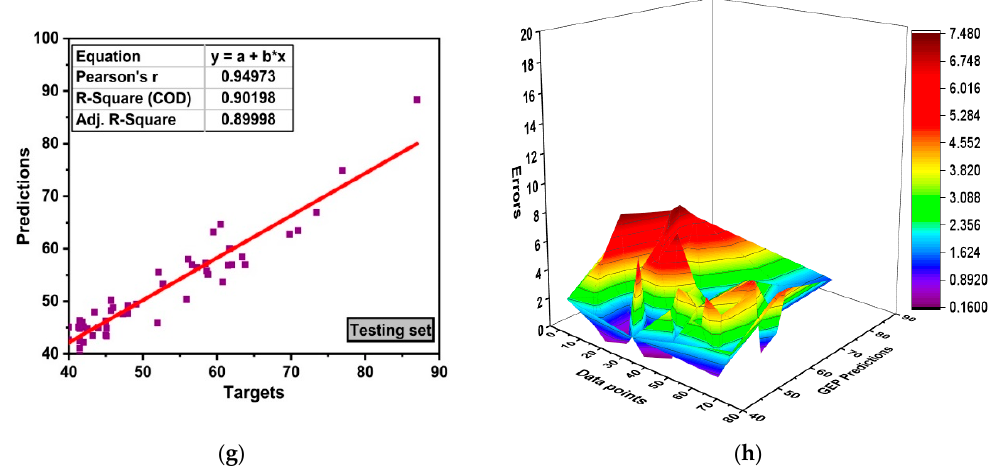
Figure 6. Model evaluation with errors ( a ) RF regression analysis; ( b ) error distribution based on the RF model; ( c ) decision tree (DT) regression analysis; ( d ) error distribution based on DT; ( e ) artificial neural network (ANN) regression analysis; ( f ) error distribution based on ANN; ( g ) GEP regression analysis; ( h ) error distribution based on GEP.